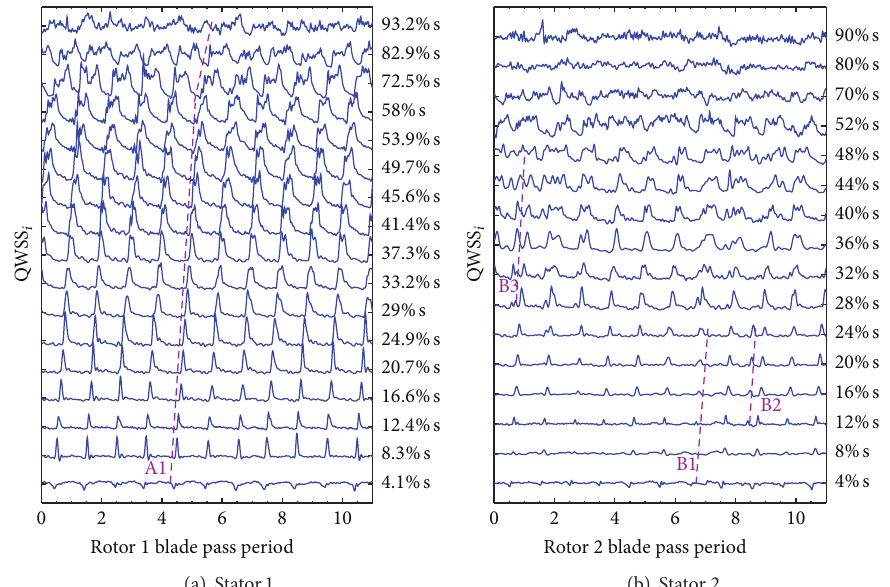
Figure 2: QWSS at peak efficiency: (a) Stator 1 and (b) Stator 2.